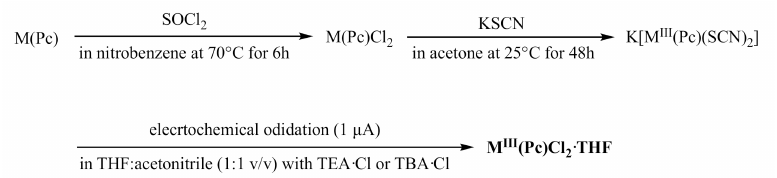
Figure 3. Schematic route for the synthesis of single crystals of M III (Pc)Cl 2 ·